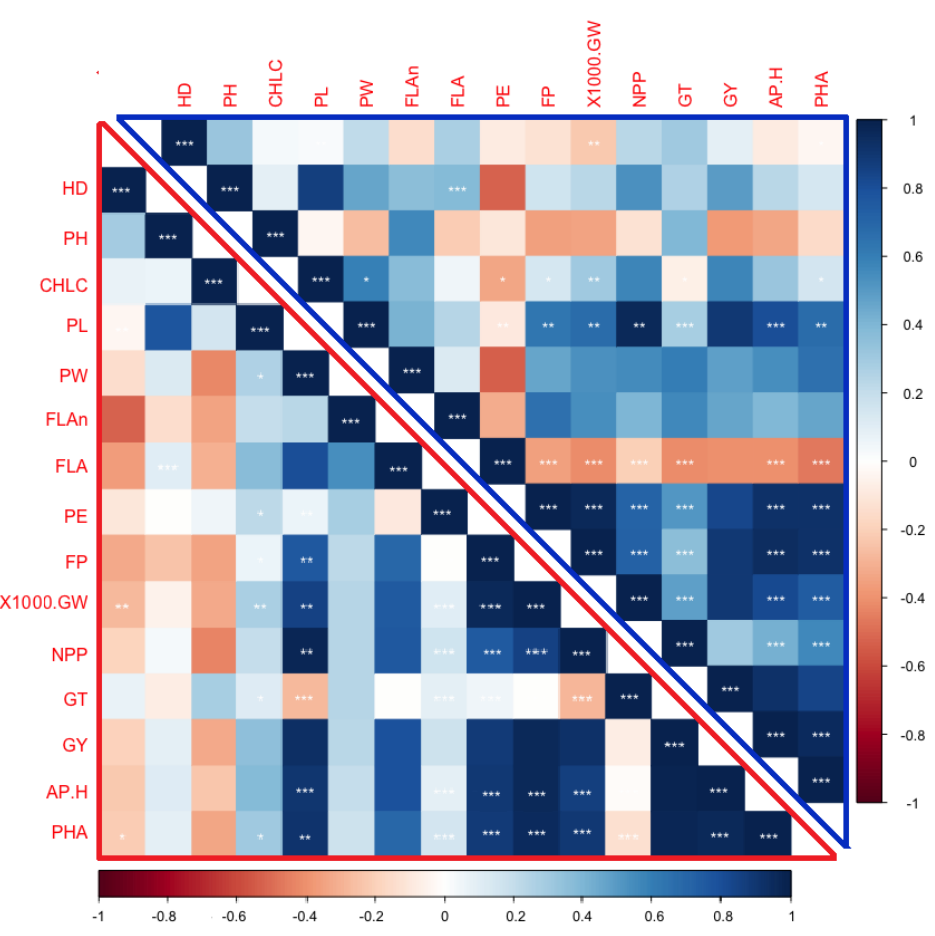
Figure 2. Corrplot depicting Pearson’s correlation between the general (upper triangle) and specific (lower triangle) combining ability for 15 yield traits across 29 genotypes. Red squares indicate a negative correlation; blue squares indicate a positive correlation; and white squares indicate no cor- relation. The asterisks indicate significant correlations using a two-tailed t -test (* and ** p < 0.05; and *** p < 0.01).